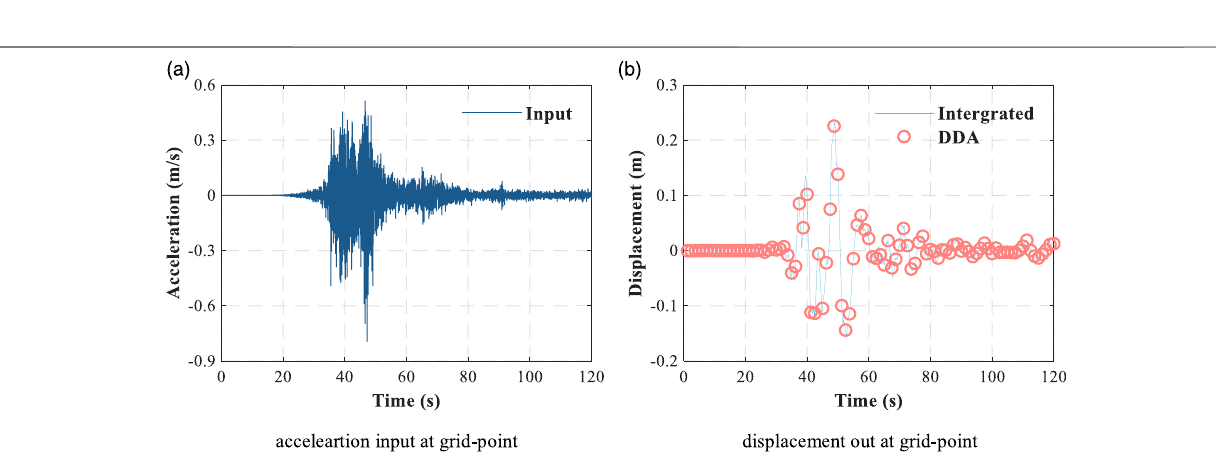
Frontiers in Earth Science |